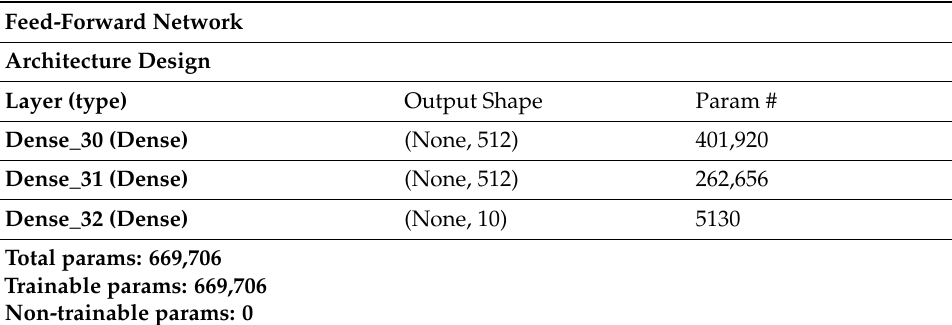
Table 3. The feed-forward architecture